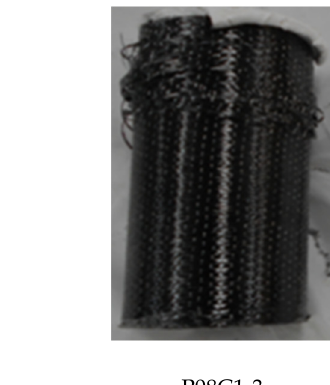
Figure 8. The illustration photo of compression test for cylindrical specimens P08C1.